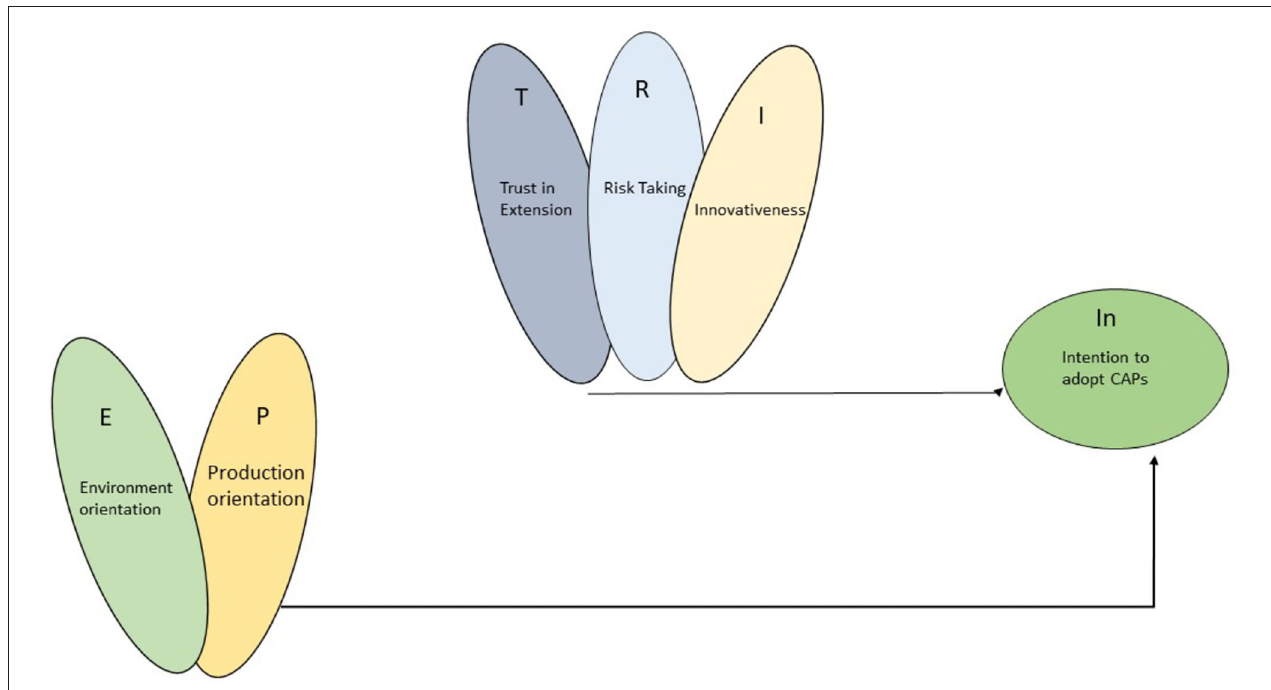
FIGURE 1 | Conceptual framework for complex